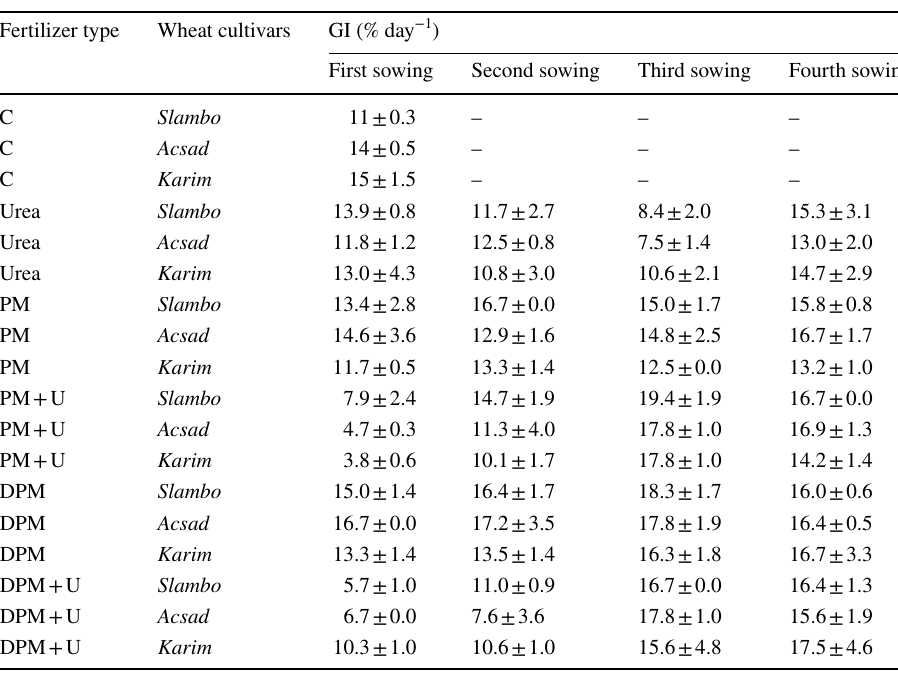
Values represent the average ± standard deviation (n = 4) – no control used in the second, third and fourth